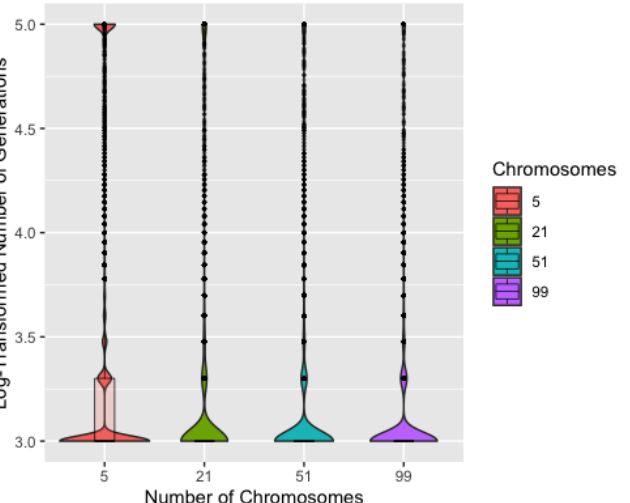
Figure 6. Boxplots and violin plots for log (base 10) number of generations to solution by number of chromosomes for 200 generations without improvement. The absence of a box for 21 or more chromosomes indicates that the median, first quartile, and third quartile are the same.